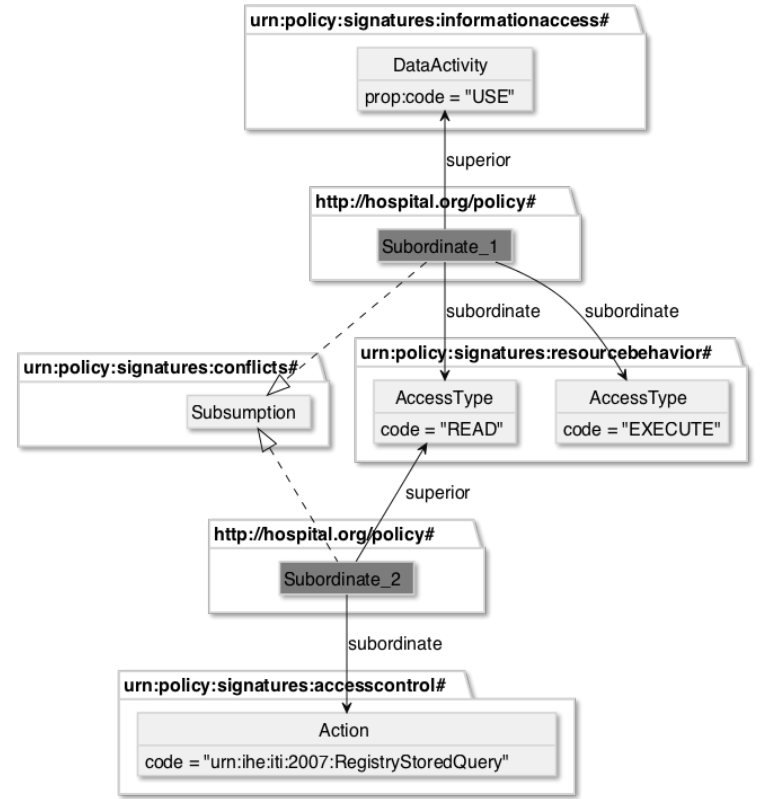
Figure 3. Object model for subsumption